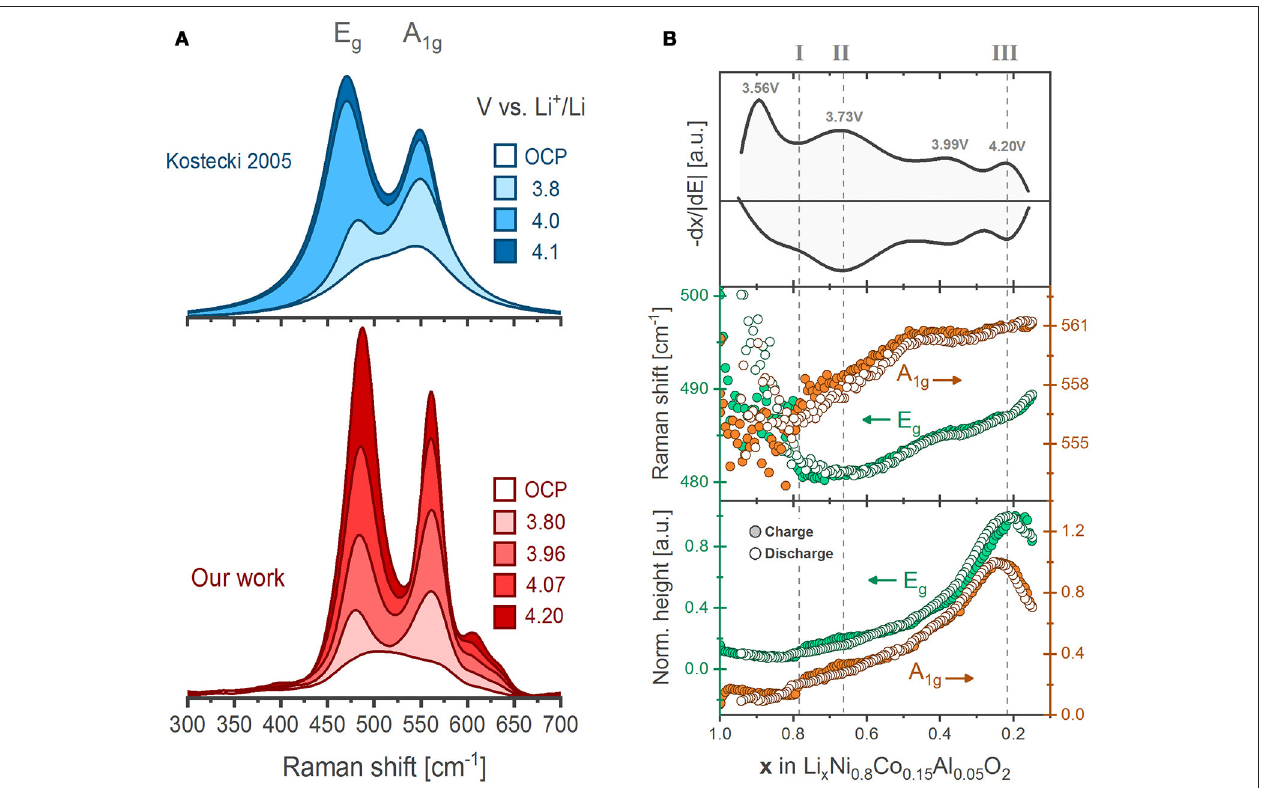
FIGURE 7 | (A) Comparison of the in situ evolution of NCA Raman spectrum as recorded by Kostecki et al. (Lei et al., 2005) and here adapted along with our results (Flores et al., 2018). (B) Differential charge plot of NCA together with the fitted peak positions and heights of the E g and A 1g bands as a function of lithium content during the first galvanostatic cycle between 3.0 and 4.3V vs. Li + /Li ( ∼ C/20 rate). Each data point result from the deconvolution of a single